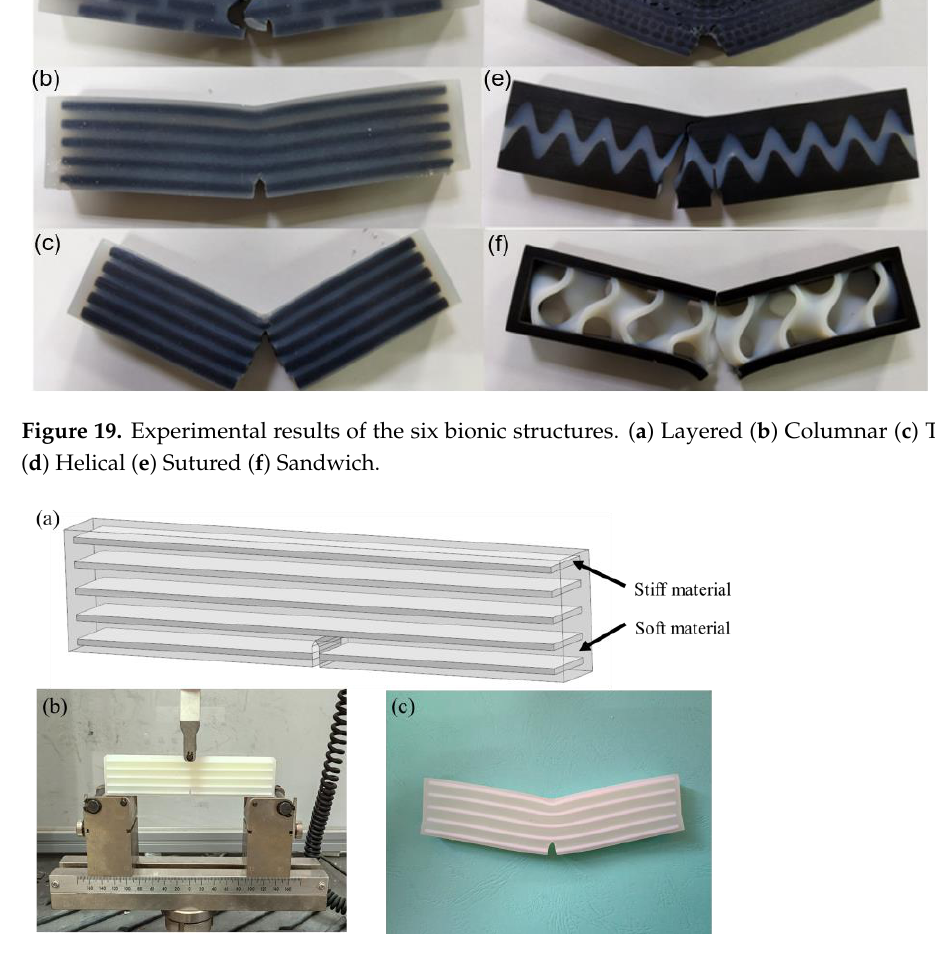
Figure 19. Experimental results of the six bionic structures. ( a ) Layered ( b ) Columnar ( c ) Tubular ( d ) Helical ( e ) Sutured ( f ) Sandwich.